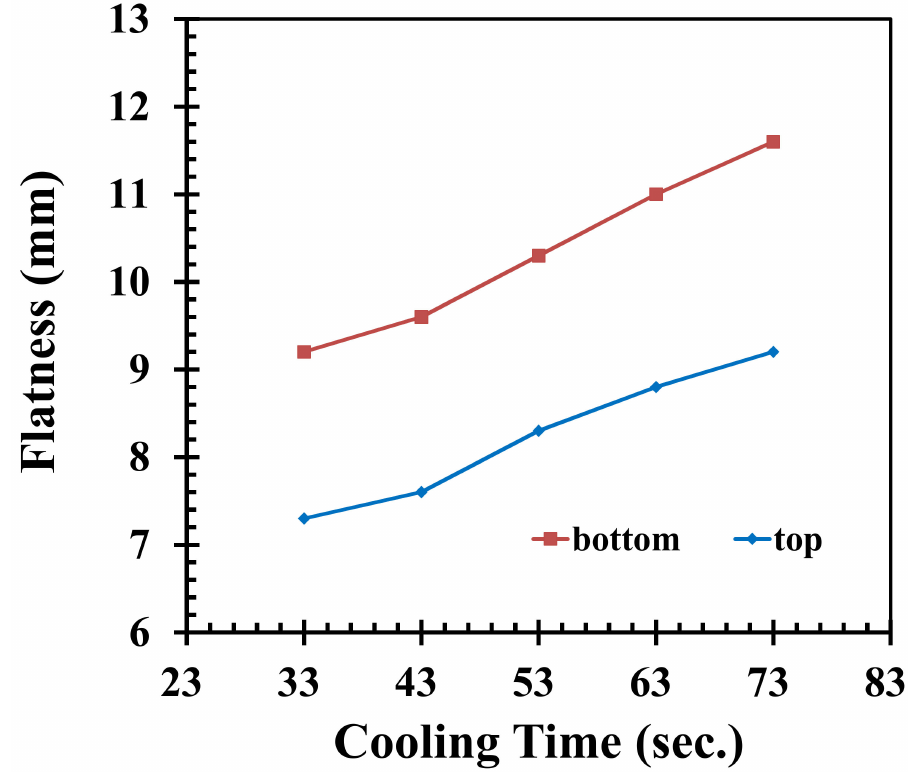
Figure 7. Influence on flatness by adjusting the cooling